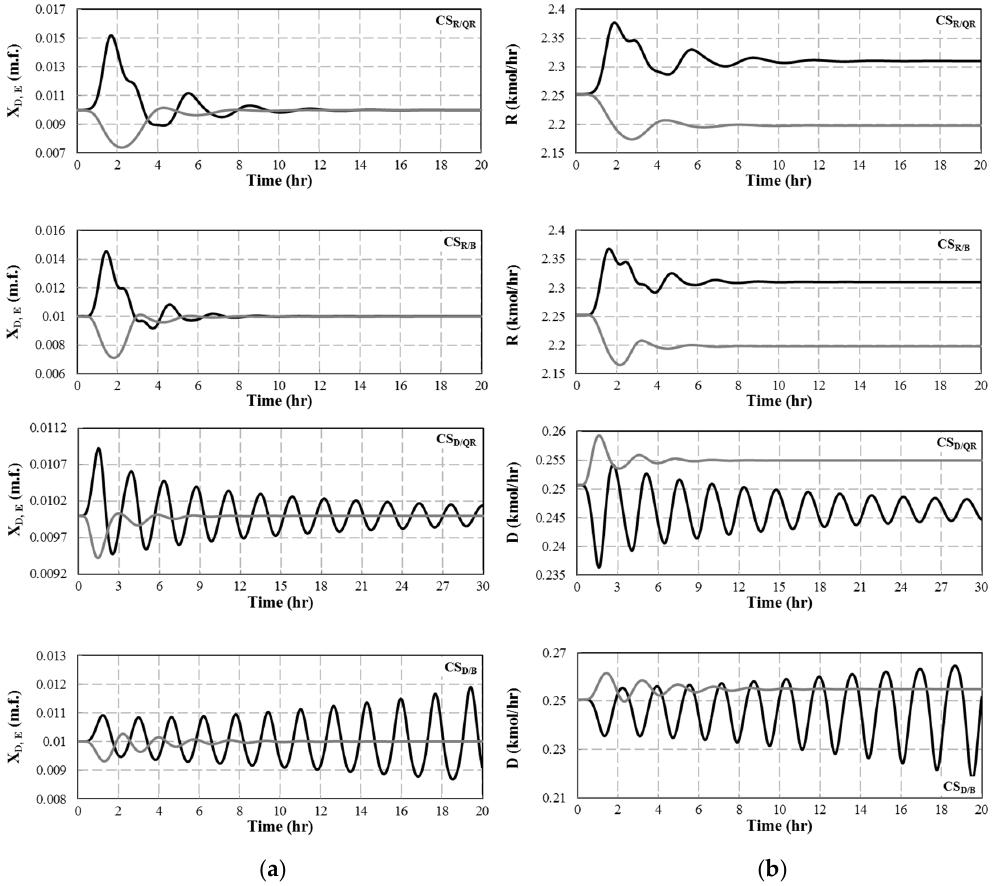
Figure 7. Dynamic responses of the top control loop of the MEPB Kaibel distillation column controlled, respectively, under the CS R/QR , CS R/B , CS D/QR , and CS D/B structures after facing a ±5% variation in E feed composition (+5%: black curves and − 5%: grey curves): ( a ) controlled variables; ( b ) manipulated variables.